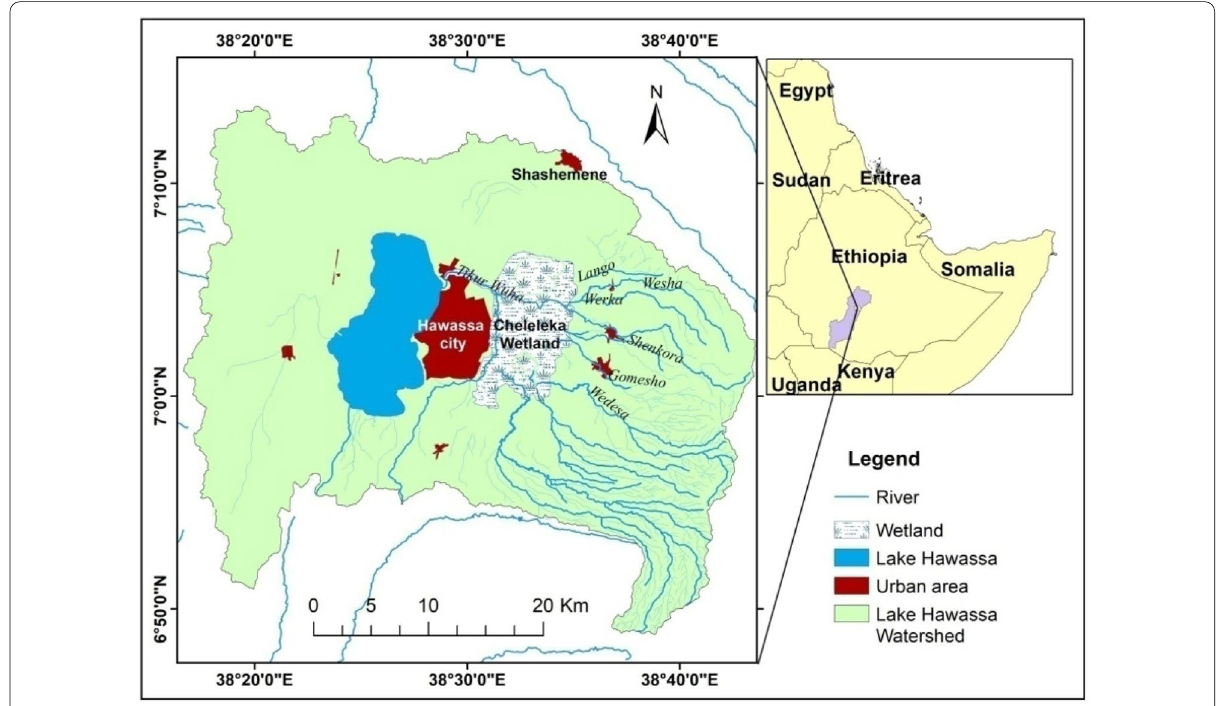
Fig. 1 Location map of the study